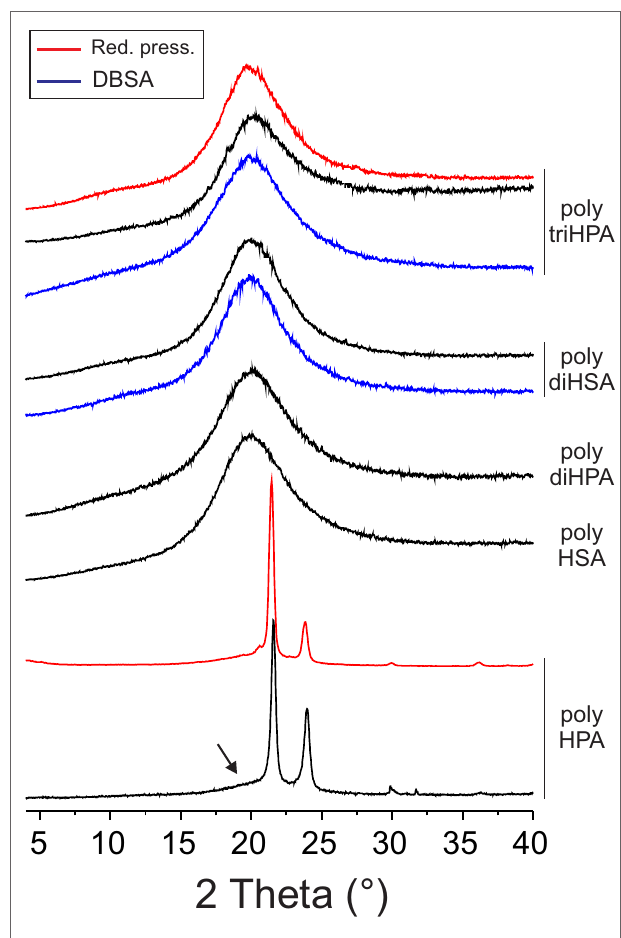
FigUre 4 | XrD diagrams of polyesters . The broad peak around 20° is typical for amorphous solids. The arrow highlights the formation of an amorphous phase in poly-HPA prepared in